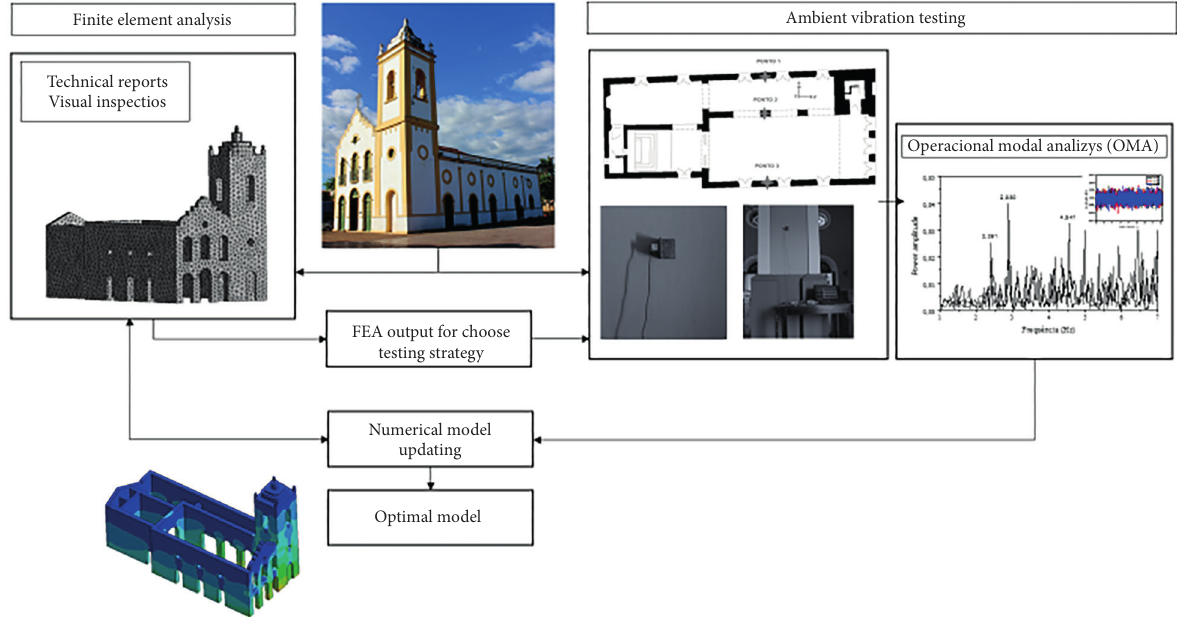
Fig. 1. Ambient vibration procedure used for Nossa Senhora das Dores Church characterization